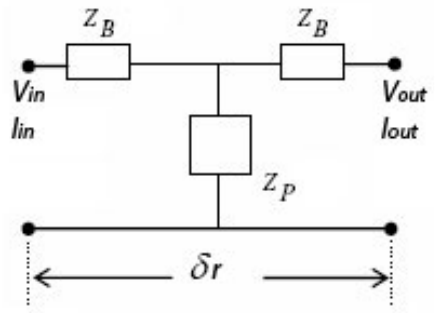
Figure 3. The equivalent quadrupole for each cylindrical sector.